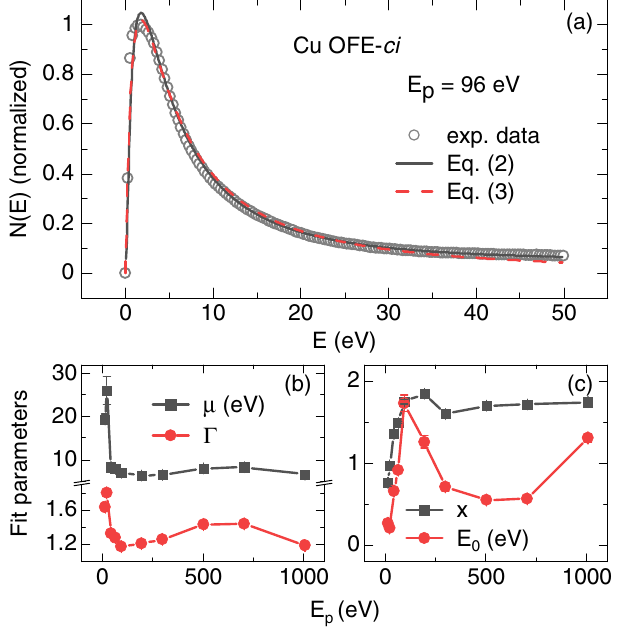
FIG. 3. Energy distribution curve, N ð E Þ , of a Cu OFE sample cleaned by Ar þ bombardment with focus on SE emission in the kinetic energy interval 0 eV ≤ E ≤ 50 eV. (a) N ð E Þ (circles) ¼ 96 eV. Fits to the data are depicted as solid acquired at E p [Eq. (2)] and dashed [Eq. (3)] lines. (b) Evolution of fit parameters μ , Γ [Eq. (2)] with E . (c) Evolution of fit parameters p x and E E for fixed Φ ¼ 4 . 5 0 [Eq. (3)] with p